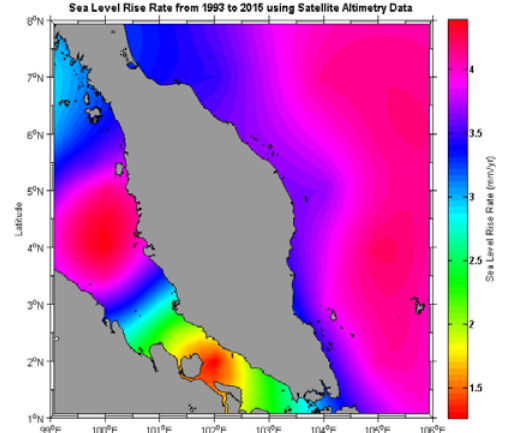
Figure 7. Map of sea level rise rate over Malacca Straits and South China Sea. The rate is computed from 23 years of altimetry data ranging from 1993 to 2015. Units are in mm/yr.